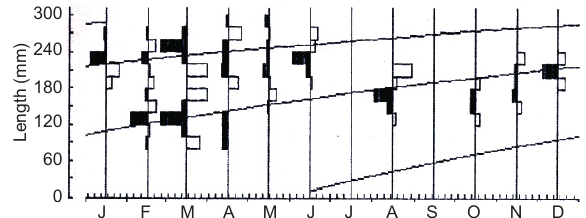
Figure 2. Growth curve of male population of Horabagrus brachysoma from River Periyar by ELEFAN 1 superimposed on the restructured length frequency diagram (L = 388mm, K = 0.51 yr -1 and Rn = 0.325) α